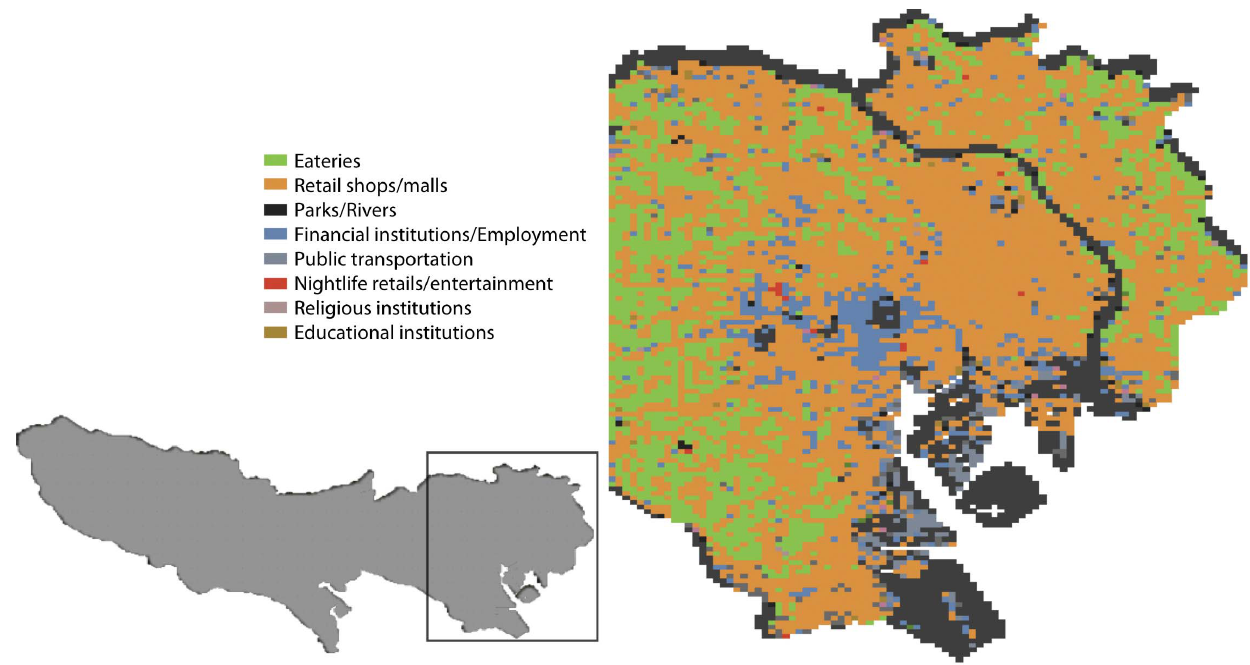
Figure 5. Partial view of Tokyo map in which most probable activities were inferred according to the yellow-pages information for each grid cell area.